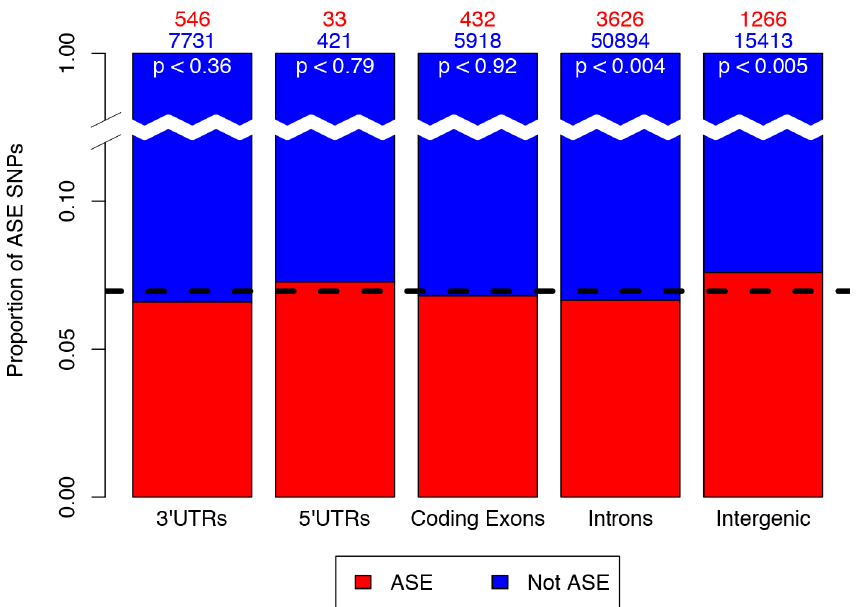
Fig 7. Proportion of SNPs annotated within transcript features categorised as ASE. Dashed black line represents the average proportion of all ASE SNPs. SNPs falling within intergenic regions (p < 0.005) are more likely to be classified ASE than SNPs falling in other regions. This observation is most likely due to the high amount of imprinted SNPs in the brain sample that do not have genic annotations.